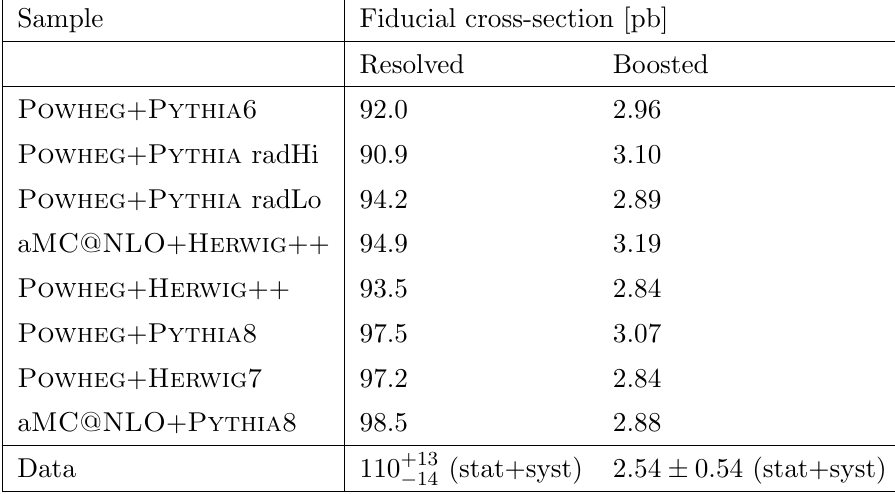
Table 7. Fiducial cross-sections in the resolved and boosted topologies for data and di(cid:11)erent models. Each model’s cross-section is scaled to the NNLO+NNLL value from refs. [34{39], hence the quoted (cid:12)ducial cross-sections result from di(cid:11)erent kinematic regions and thus acceptance from each